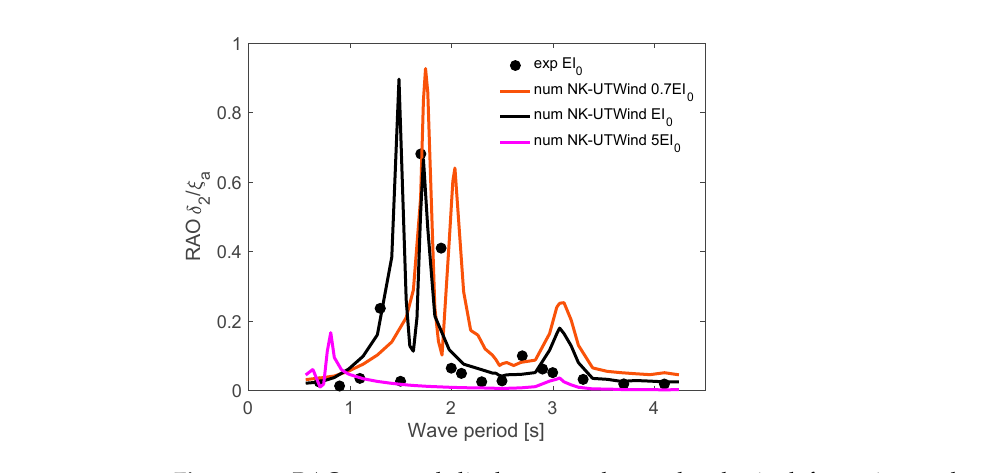
Figure 16. RAO punctual displacement due to the elastic deformation at the deck edge result comparisons between the experiment and NK-UTWind numerical calculation for different structural rigidities.